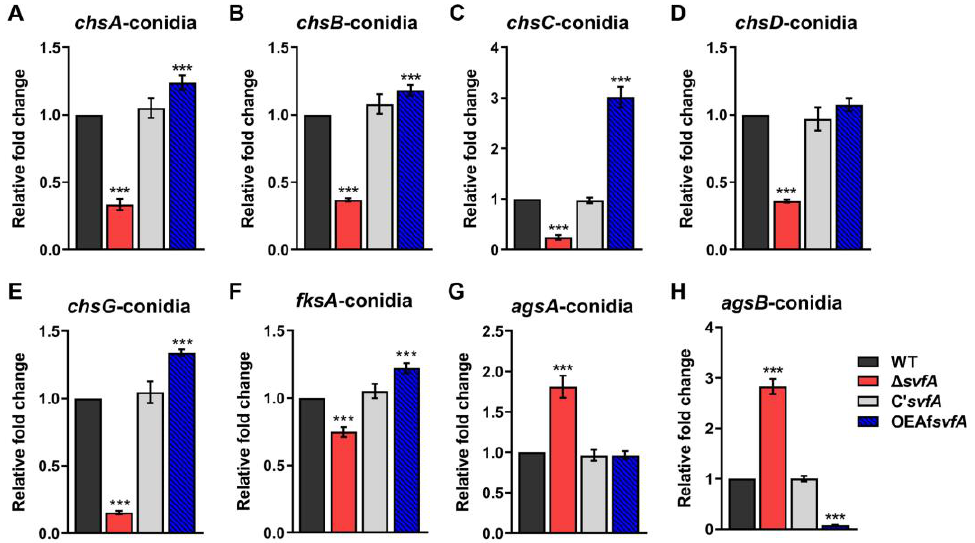
Figure 4. Role of SvfA in the regulation of the expression of cell-wall-associated genes. Conidia were inoculated on GMM, incubated for 2 – 3 d, and harvested using 0.08% Tween 80 solution. Total RNA was extracted and used for cDNA synthesis. RT-qPCR analysis was performed using the 18S rRNA gene as an internal control. ( A – E ) Expression levels of chitin synthase genes, chsA , chsB , chsC , chsD , and chsG . N = 8 – 10. ( F ) Expression level of β -1,3-glucan synthase gene, fksA . N = 9 – 10. ( G – H ). Expression levels of α -1,3-glucan synthase genes agsA and agsB . N = 10. *** p < 0.001.